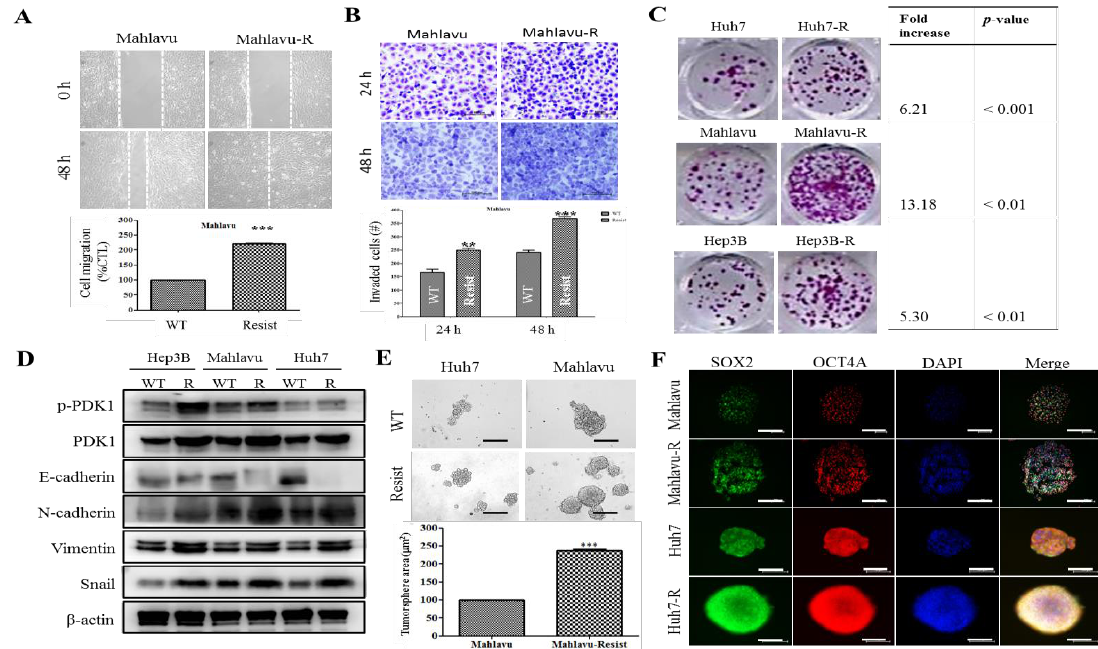
Figure 4. PDK1-dependent radioresistance is associated with the enhanced metastatic and cancer stem cell-like phenotypes of HCC cells. Representative photo-images (upper panel) and histograms (lower panel) comparing ( A ) migration and ( B ) invasion potential between Mahlavu and Mahlavu-R cells. Scale bar: 100 µ m, 10 × objective. ( C ) Representative photo-images (left panel) comparing clonogenicity between Huh7-R, Mahlavu-R, Hep3B-R and their wild-type counterparts. Scale bar: 100 µ m, 10 × objective. ( D ) Representative Western blot images of the differential expression of p-PDK1, PDK1, E-cadherin, N -cadherin, Vimentin or Snail protein in wild-type and IR-resistant Hep3B, Mahlavu or Huh7 cells. β -actin was used as a loading control. ( E ) Representative photo-images (upper panel) and histograms (lower panel) comparing the tumorsphere formation potential between wild-type (WT) and IR-resistant Huh7 or Mahlavu cells. Scale bar: 100 µ m, 10 × objective. ( F ) Representative immunofluorescence staining images of SOX2 and OCT4A expression in WT and IR-resistant Huh7 or Mahlavu cells. DAPI served as nuclear marker. Scale bar: 100 µ m, 10 × objective. * p < 0.05, ** p < 0.01, *** p < 0.001.